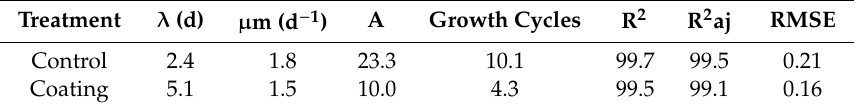
Table 3. Growth kinetic parameters of total mesophilic aerobic microorganisms calculated from the application of the modified Gompertz model.